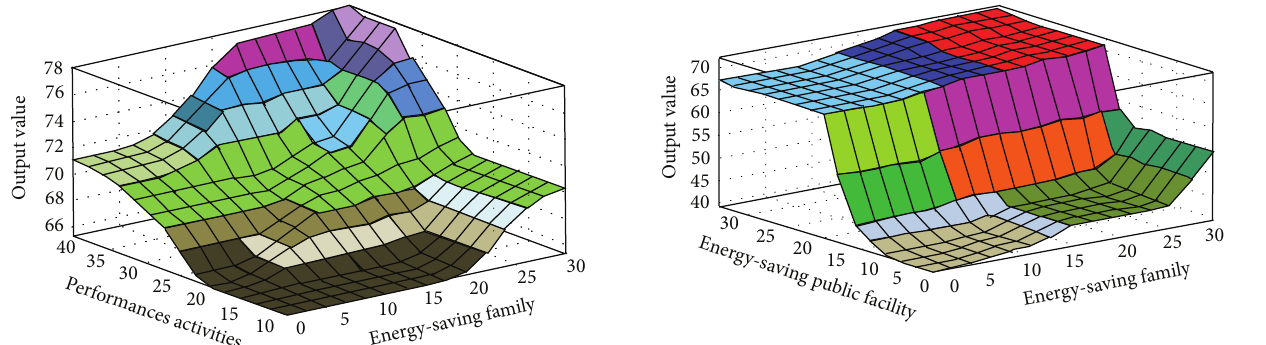
Figure 4: Input and output 3D mapping (performances activities and energy-saving family).